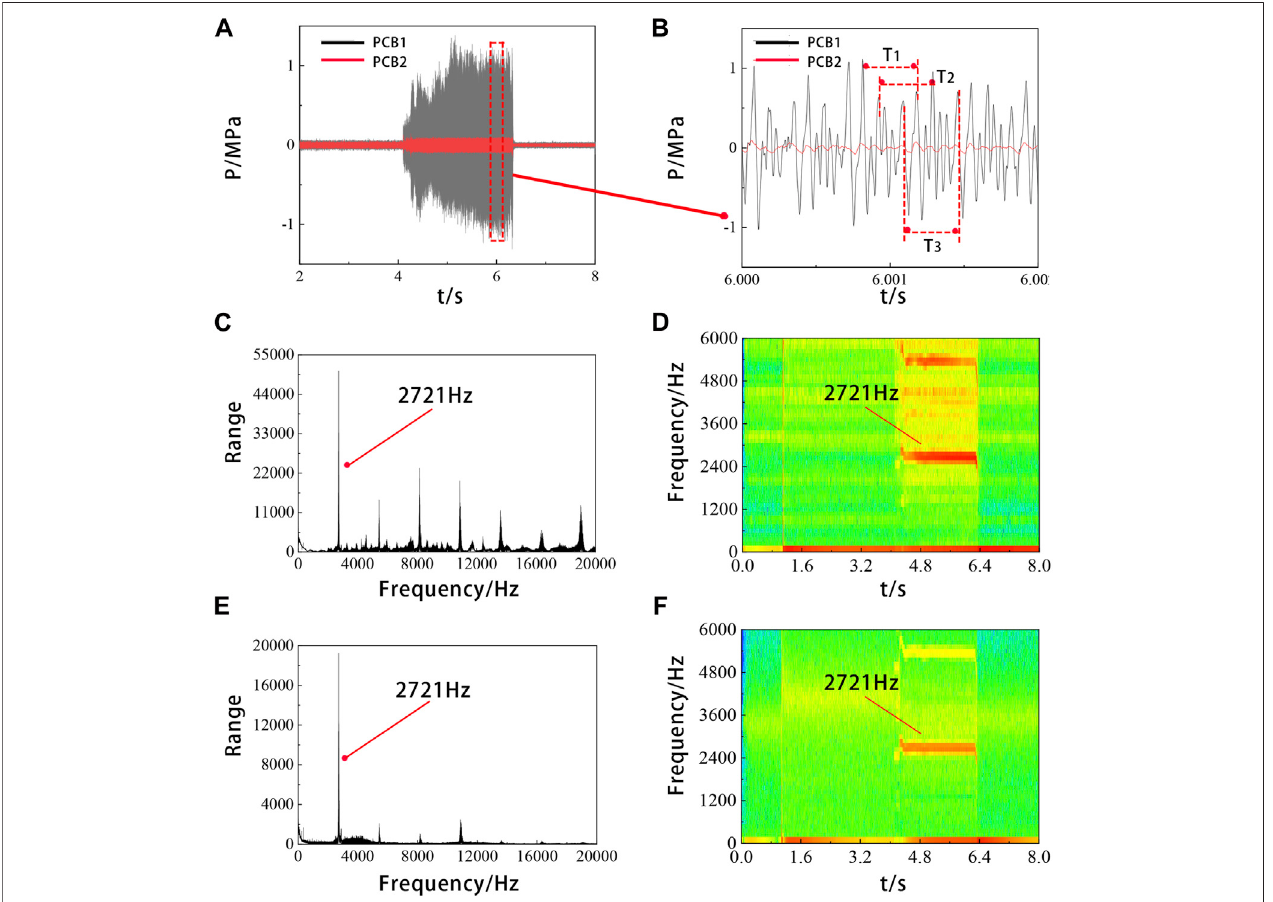
FIGURE9| ResultsofoperatingatT 0 (cid:1) 650K, _ m air (cid:1) 1 . 5kg/s,and φ (cid:1) 0 . 98. (A) High-frequencypressuresignalsintheisolation; (B) Localhigh-frequencypressure signals; (C) The FFT frequency distribution by PCB 1 ; (D) The STFT frequency distribution by PCB 1 ; (E) The FFT frequency distribution by PCB 2 ; (F) The STFT frequency distribution by PCB 2